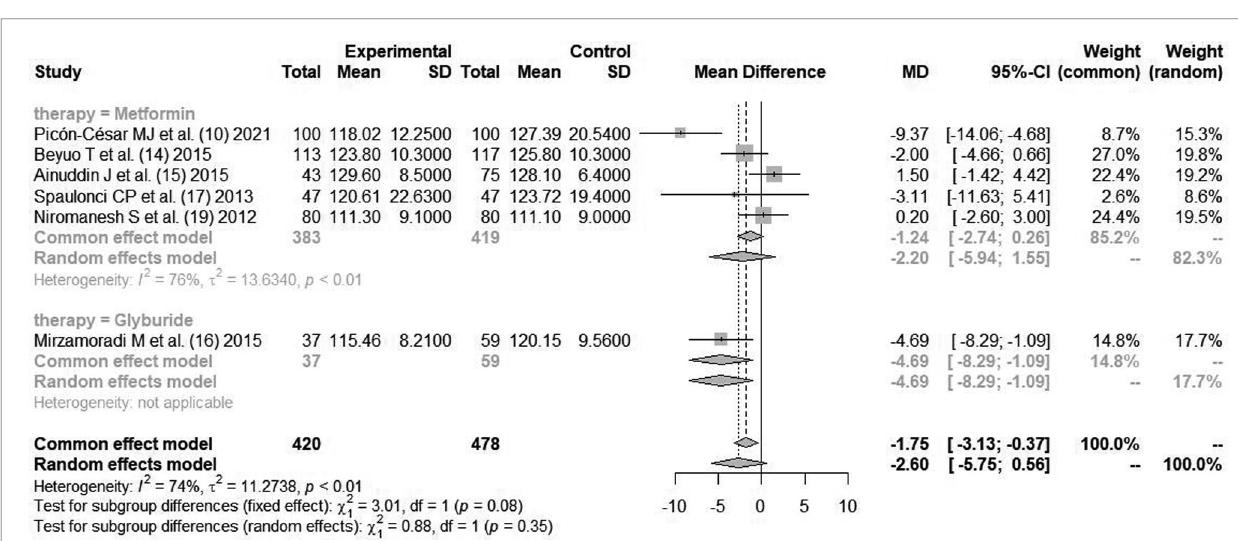
FIGURE 3 | Comparison of postprandial glycemia after lunch during pregnancy.